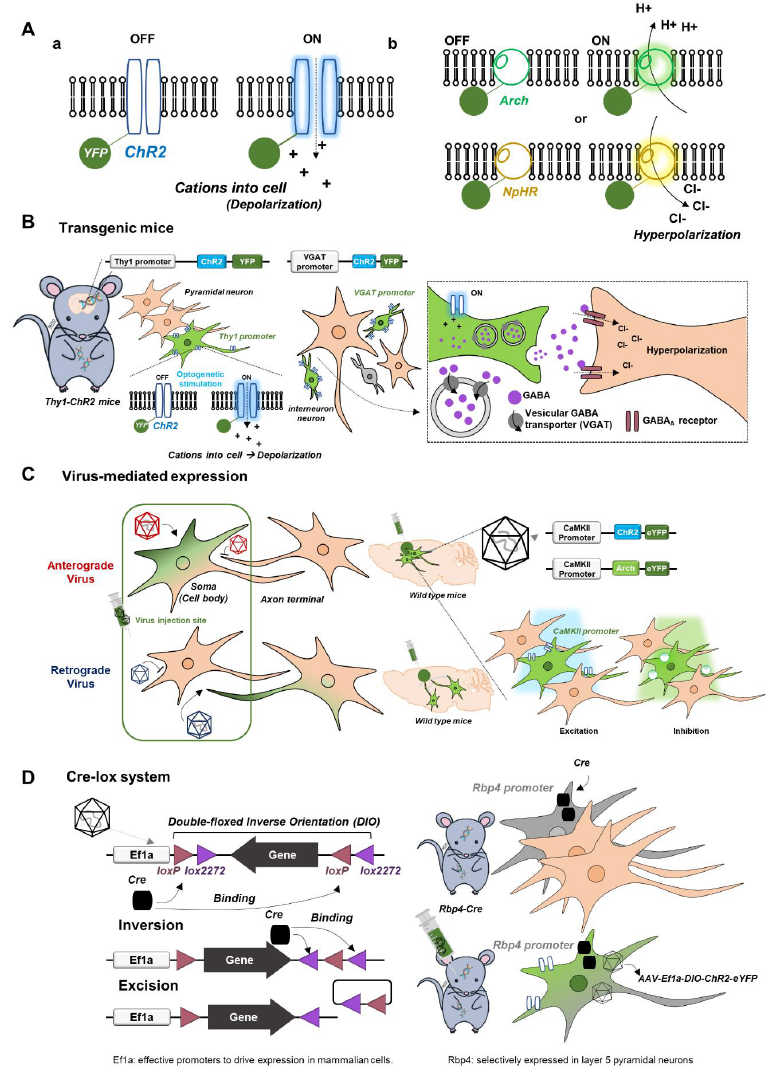
Figure 1. Basics of optogenetics relevant to fMRI. ( A ) Light-sensitive opsins. Channelrhodopsin2 (ChR2; nonspecific cation channel), a representative excitatory opsin, which causes membrane depolarization ( a ). Inhibitory opsins such as halorhodopsin (NpHR; inward chloride pump) and archaerhodopsin (Arch; outward proton pump), which cause membrane hyperpolarization ( b ). ( B – D ) Three different approaches for the expression of light-sensitive opsins. ( B ) Transgenic mice with opsins in cell-type specific neurons. Transgenic Thy1-ChR2 mice for optogenetic excitation of pyramidal neurons. Transgenic VGAT-ChR2 mice for optogenetic inhibition of pyramidal neurons. ( C ) Virus-mediated expression of opsins for promotor-based gene delivery into neurons. Anterograde infection from cell bodies to axon terminals. Retrograde infection from axon terminals to cell bodies. ( D ) Cre-lox system for site- and cell-specific optogenetics. Diagram of the double-floxed inverse orientation (DIO) transgenic